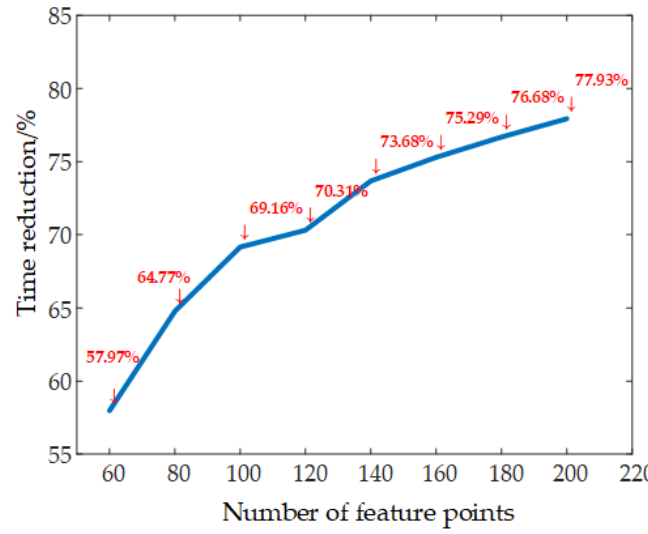
Figure 14. Time reduction rate curve after template merging.